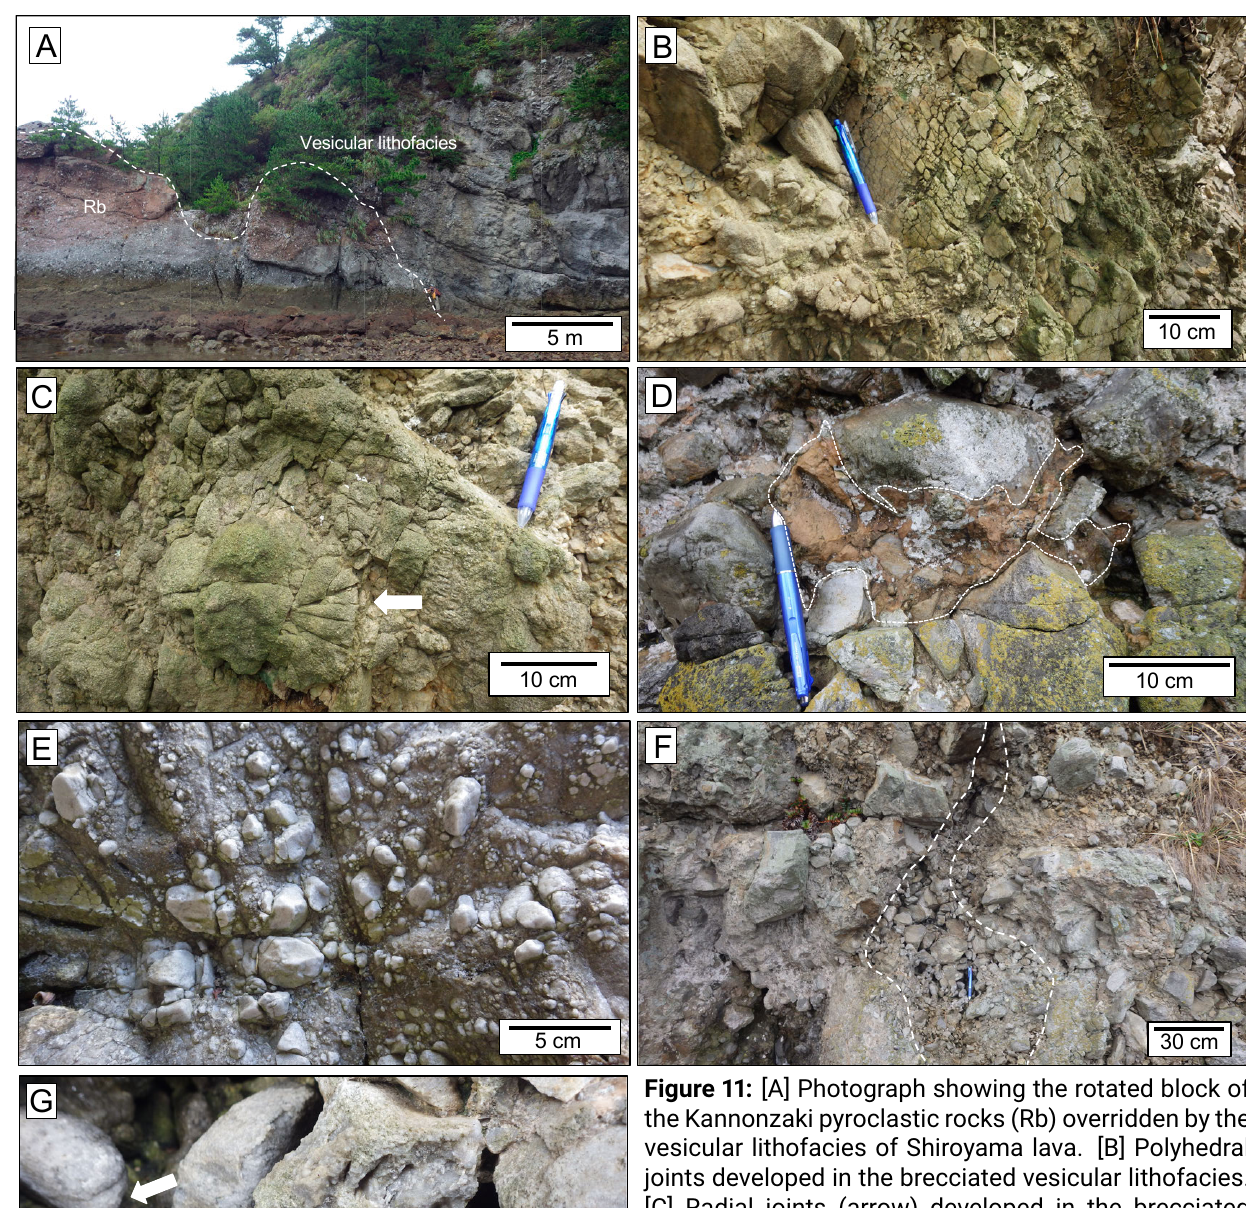
Figure 11: [A] Photograph showing the rotated block of the Kannonzaki pyroclastic rocks (Rb) overridden by the vesicular lithofacies of Shiroyama lava. [B] Polyhedral joints developed in the brecciated vesicular lithofacies. [C] Radial joints (arrow) developed in the brecciated vesicular lithofacies. [D] Reddish mud deposits (dotted line) indicating peperites. [E] Perlitic texture resembling the macro perlite of Yamagishi and Goto [1992]. [F] Sec- tion showing a clastic dike. Dotted lines indicate the out- lines. [G] Glassy clasts showing ductile deformation and adhesion each other